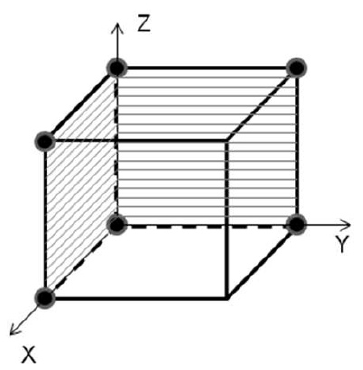
Figure 5. An example of the calibration points choice.